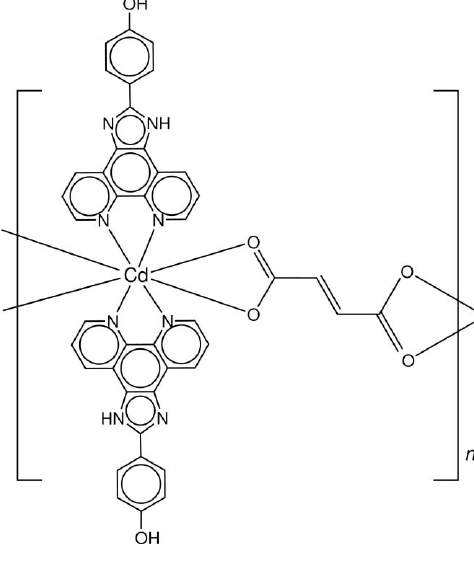
Experimental Crystal data H O )- 4 2 4